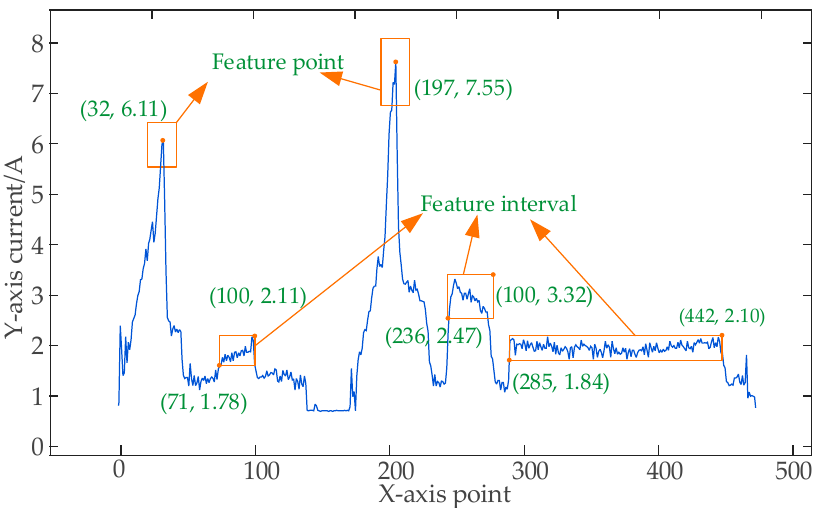
Figure 3. Schematic diagram of feature vector calibration. Algorithm 1 : Pseudo code of real-time